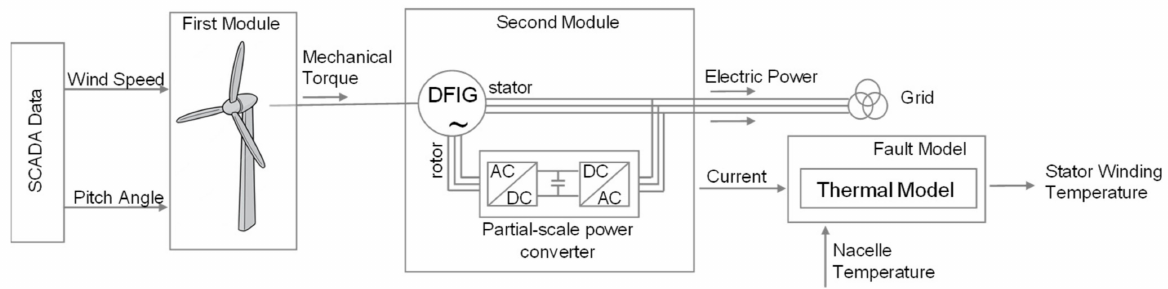
Figure 4. Failure hybrid model with a specific thermal failure